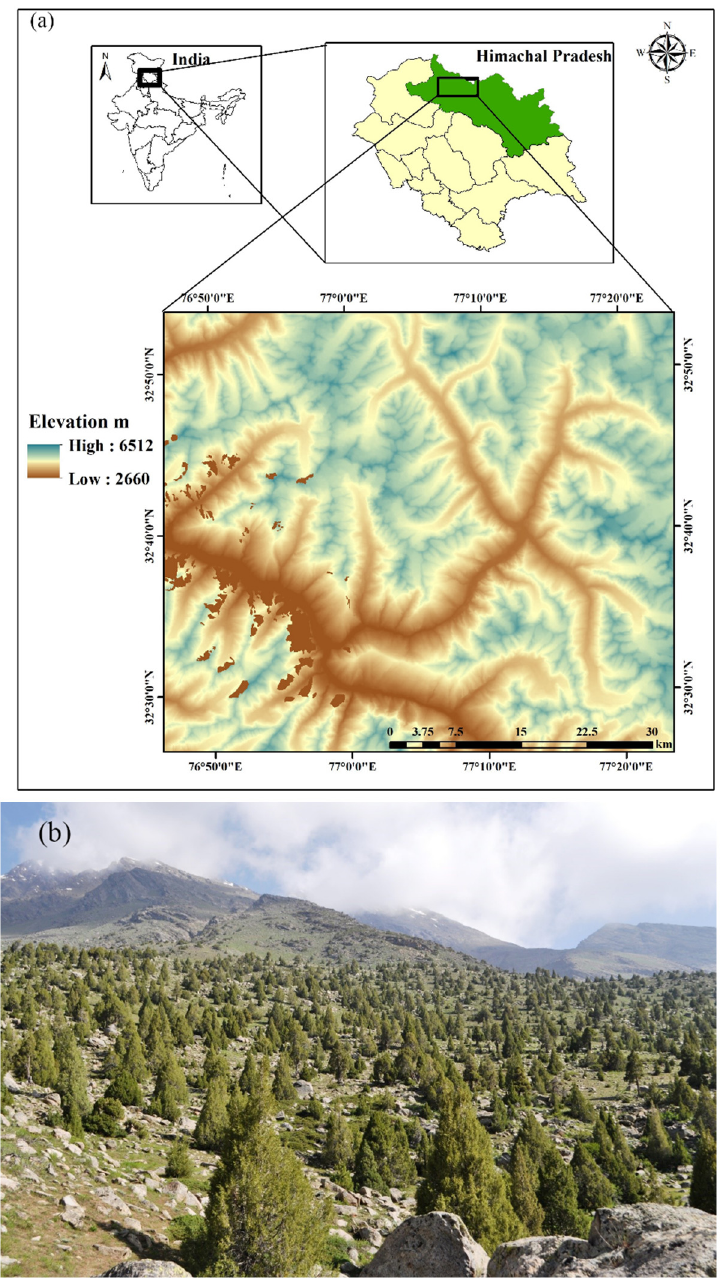
Figure 1. ( a ) Map of the study area and ( b ) Juniperus macropoda treeline site at Lahaul valley of north-western Himalaya.